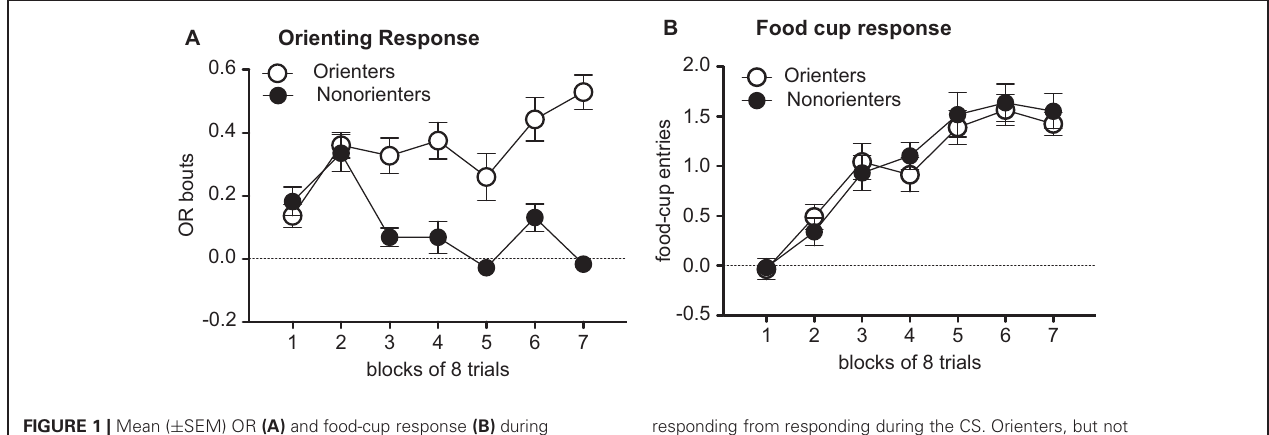
FIGURE 1 | Mean ( ± SEM) OR (A) and food-cup response (B) during training. OR bouts were measured during the first 5 s of each CS and food-cup entries were measured during the last 5 s CS period. The values shown are elevation scores, calculated by subtracting pre-CS baseline